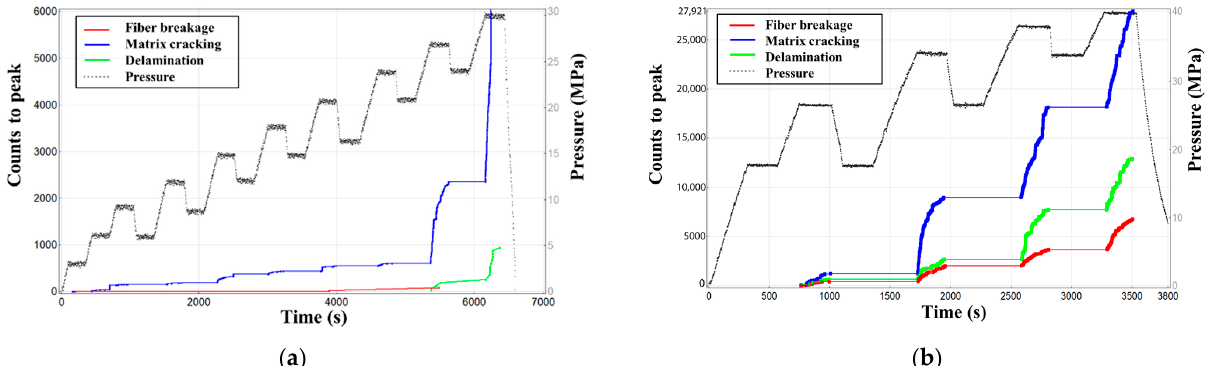
Figure 11. Damage mode evolution diagram of AE signal in hydraulic test of 0–30 ( a ) and 0–40 MPa ( b ).